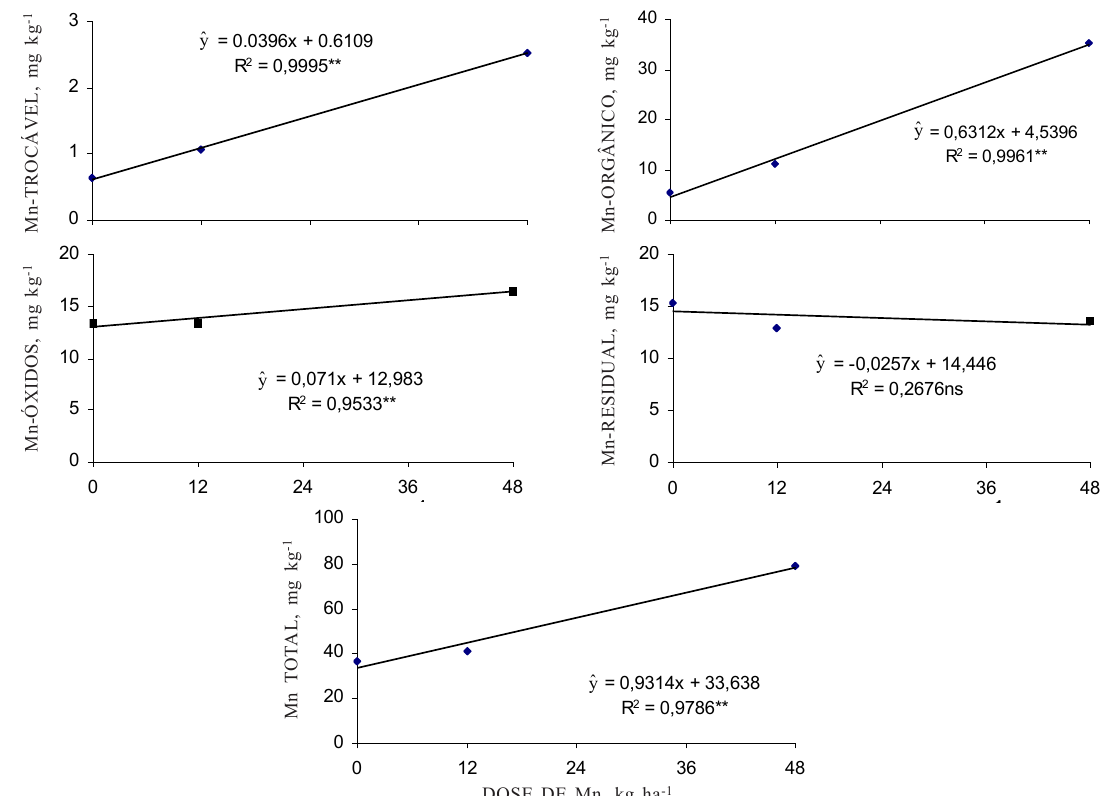
Figura 1. Formas de manganês extraídas do Cambissolo Húmico do Local I (Faz. Santa Rosa), considerando as doses de manganês aplicadas. Os dados originais apresentados foram transformados em x 1/2 para as análises estatísticas. ** significativo a 1